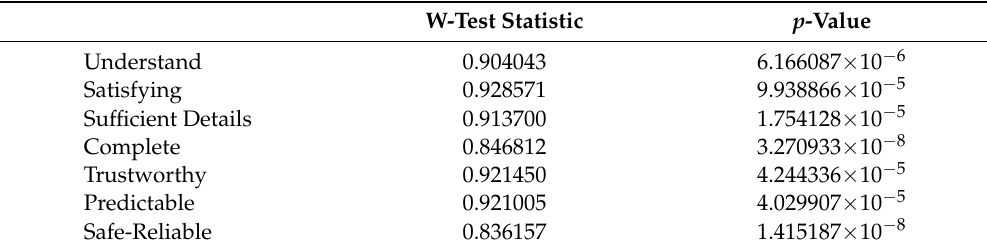
Table A6. Shapiro-Wilk test results for “Why not”